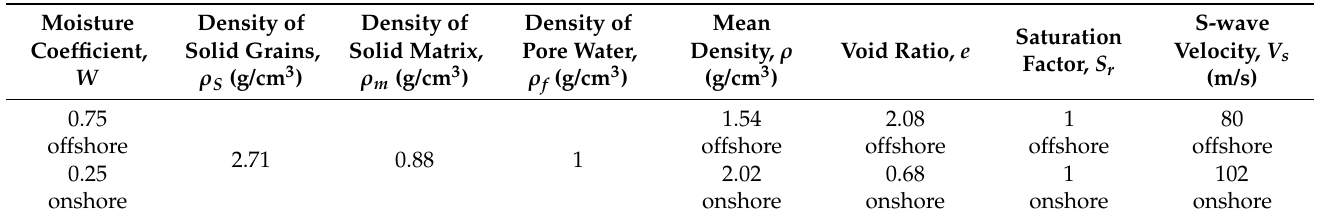
Table 4. Input parameters for the case of soft clay layer underlain by the flysch half-space.